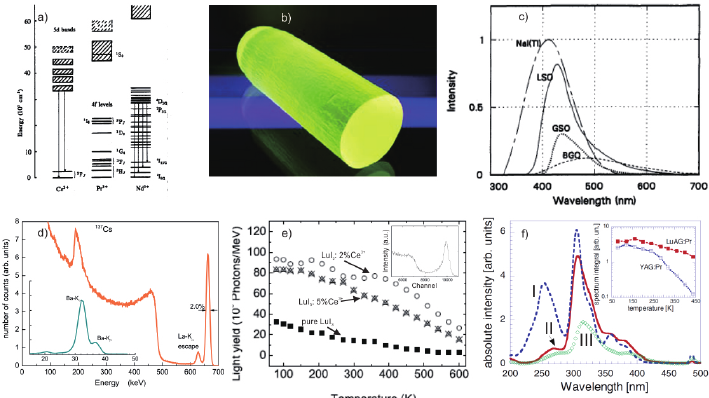
Figure 3. Trivalent lanthanide-doped scintillators: ( a ) Schematic of 4f levels and 5d bands of Ce 3 + , Pr 3 + and Nd 3 + ions in a host lattice. ( b ) Polished cut of Lu 3 Al 5 O 12 : Ce 3 + , cerium-doped lutetium